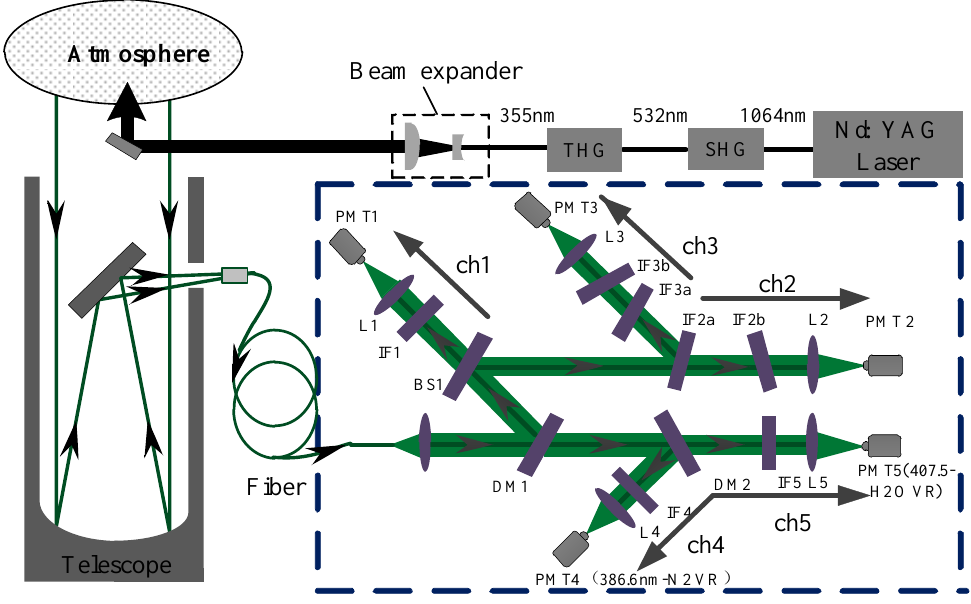
Figure 1. Schematic diagram of the Raman-Mie lidar system: DM-dichroic mirror; BS-beam splitter; IF-interference filter; L-lens.